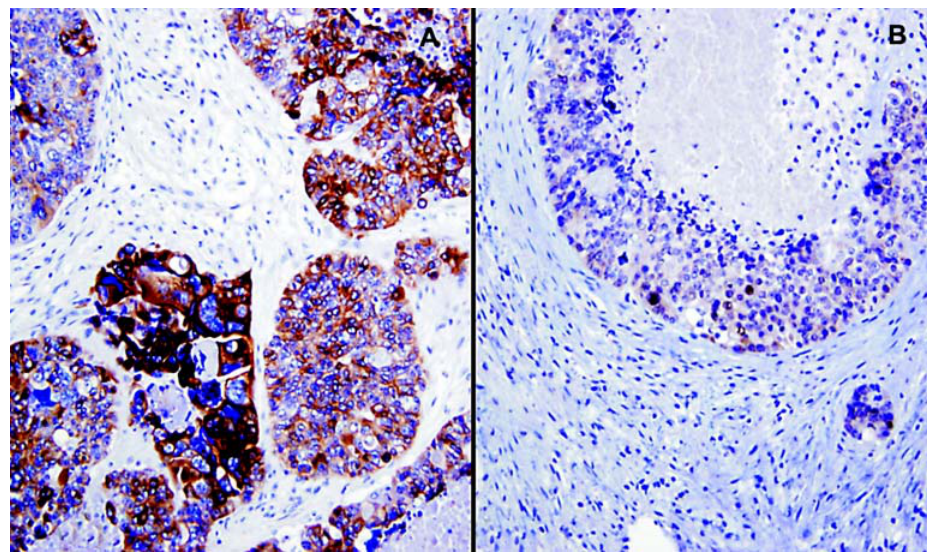
Figure 5 – Similar to colorectal adenocarcinoma, the urothelial-type adenocarcinoma was diffusely positive for CK20 (A) and CDX2 (B), Immunolabelling,